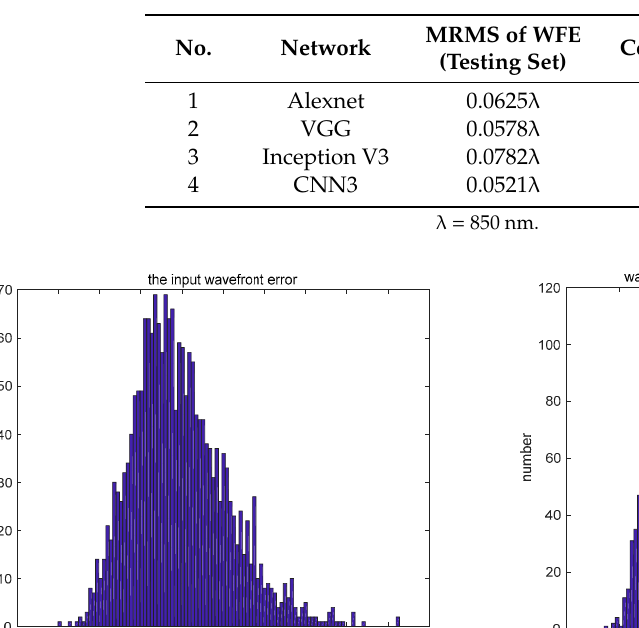
Figure 4. ( a ) The system used in the experiment and ( b ) the PSF of the defocused plane. Table 4. The results of the experiment.